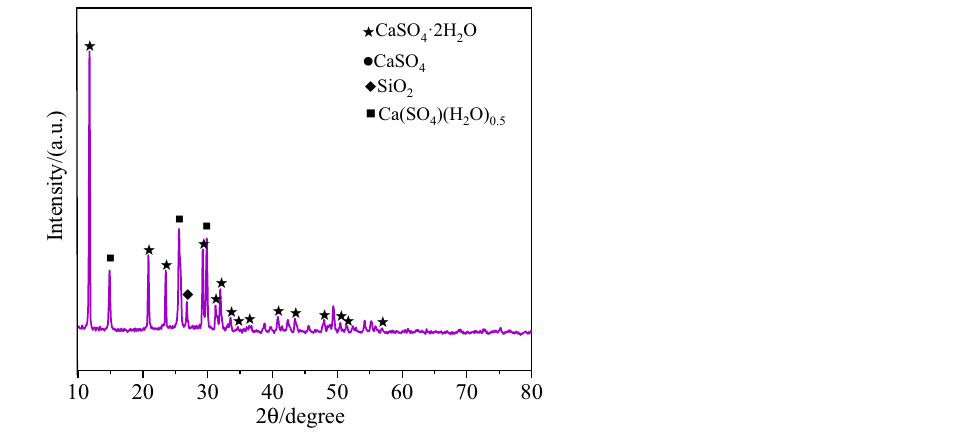
Figure 1. Physical phase composition of phosphogypsum.